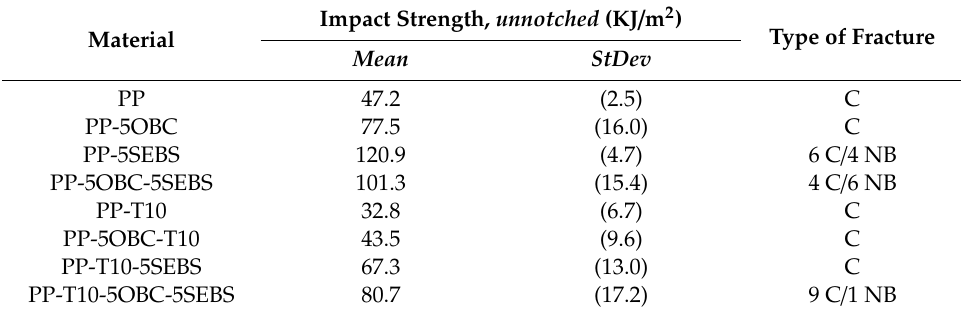
Table 4. Results of unnotched Izod impact